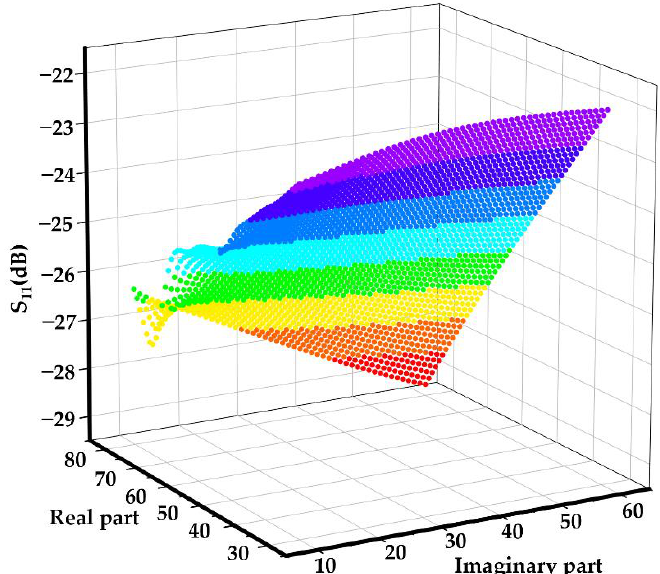
Figure 7. Variation of S 11 (dB) for different materials.